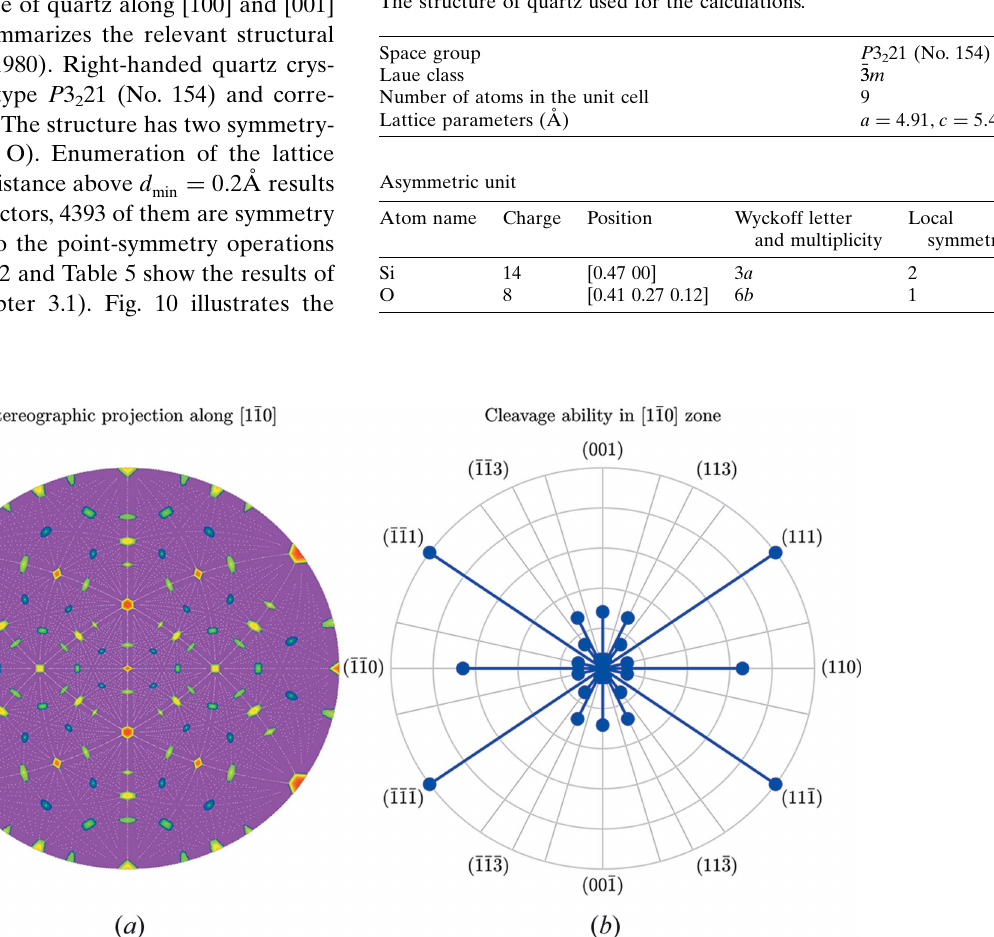
Table 4 The structure of quartz used for the